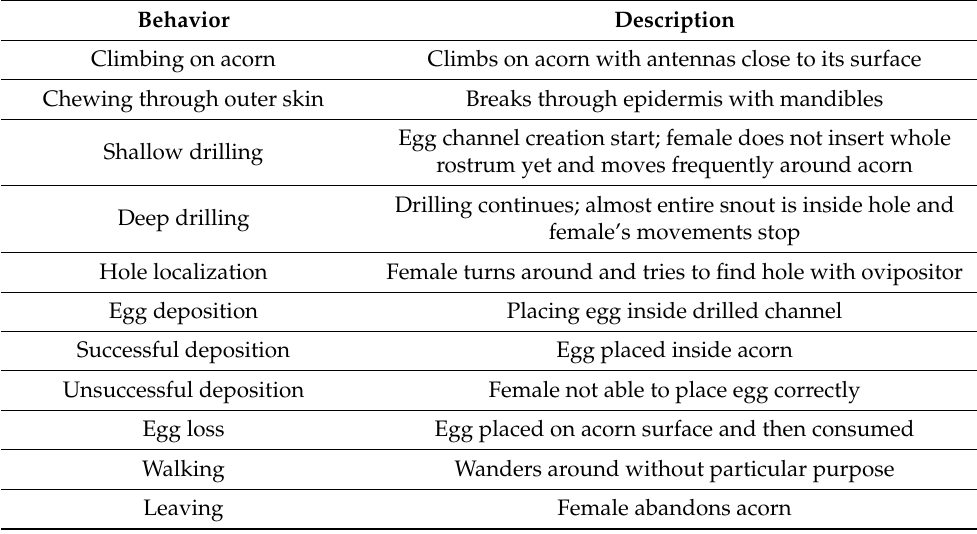
Table 2. Ethogram of C. glandium female during oviposition.